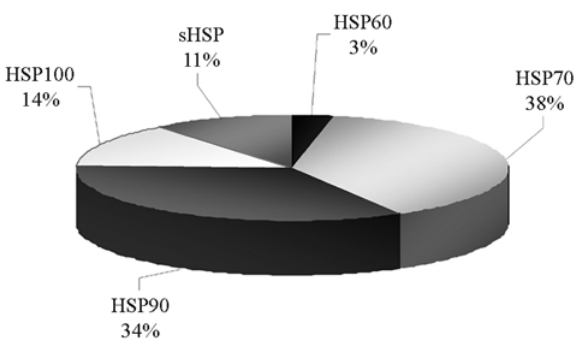
Figure3 -RelativeabundanceofHSPfamiliesinvolvedinwaterstressre- sponse in the citrus EST